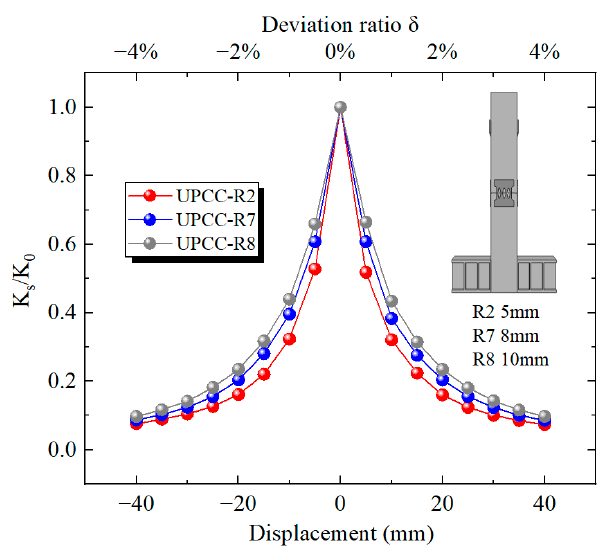
Figure 34. Degradation stiffness under different thicknesses of EREDL.